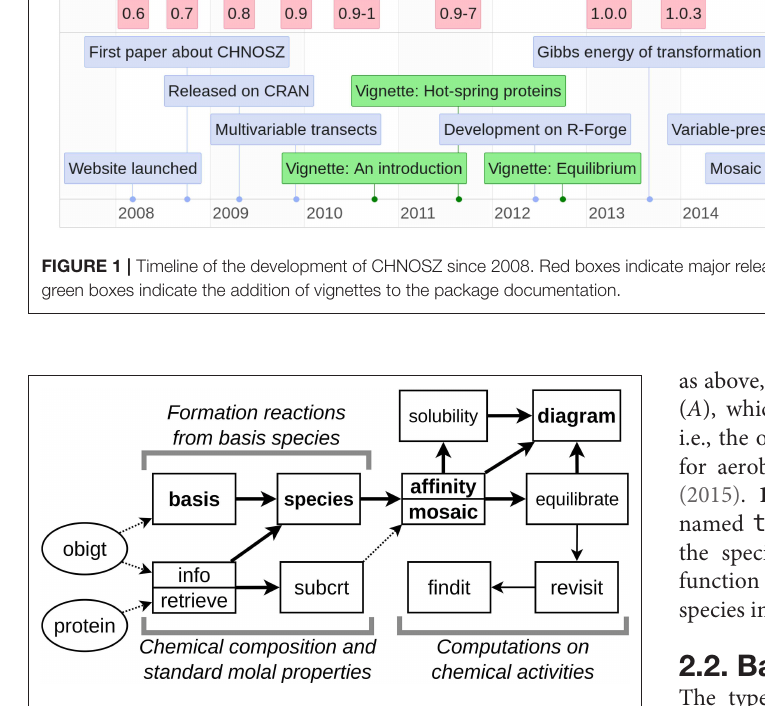
FIGURE 2 | Databases (ellipses) and major functions (rectangles) in CHNOSZ. Thick lines represent the main workflow, thin lines the extended workflow, and dotted lines the transfer of data between functions. Bold text indicates functions used in the maximum affinity method for predominance diagrams. Split rectangles represent pairs of similar functions with more basic (top) and advanced (bottom)